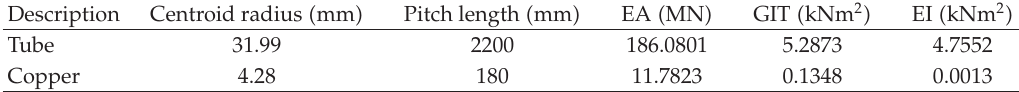
Table 8: Umbilical 5 parameters.